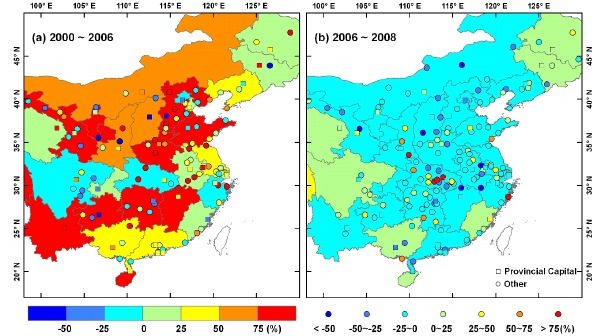
Fig. 5. Comparison of the percentage change of SO 2 emission (provinces) and SO 2 concentration (cities) in China: (a) from 2000 to 2006, and (b) from 2006 to 2008. Squares represent provincial capitals, municipalities, and capitals of autonomous